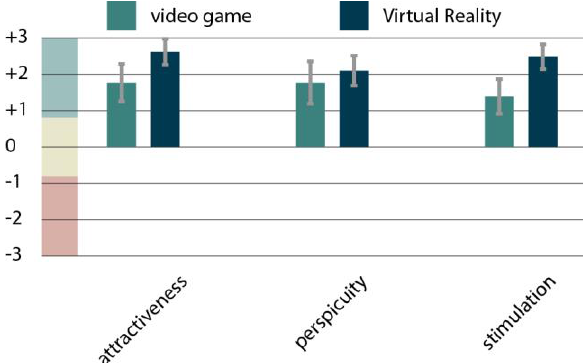
Figure 16. Results of the UEQ (the error bars represent the 95% confidence intervals of the scale